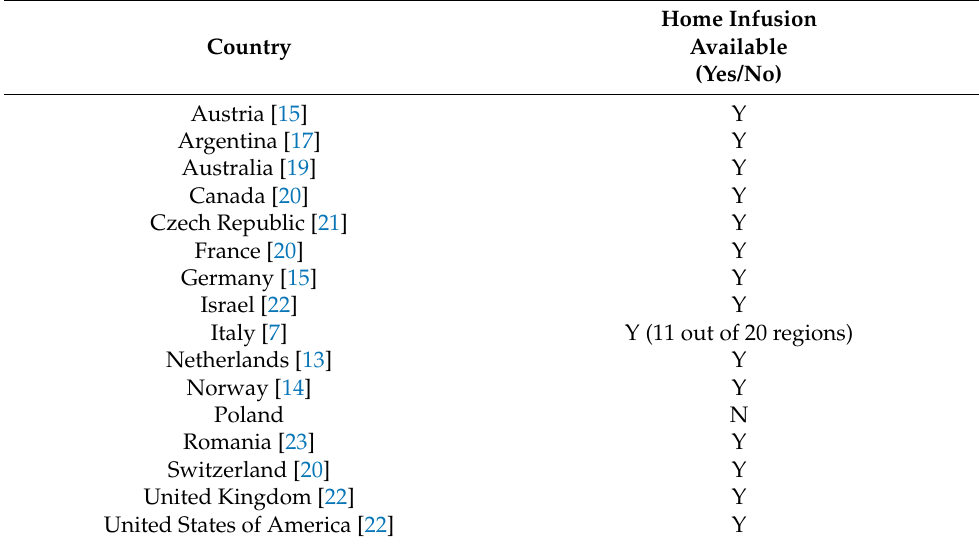
Table 1. Availability of home-based ERT programs for Fabry disease in various countries.